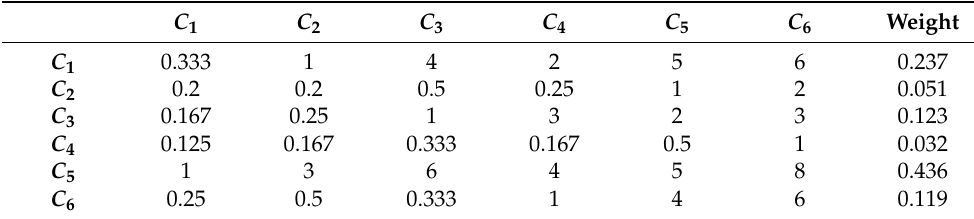
Table 5. The pairwise comparison matrix for criteria.